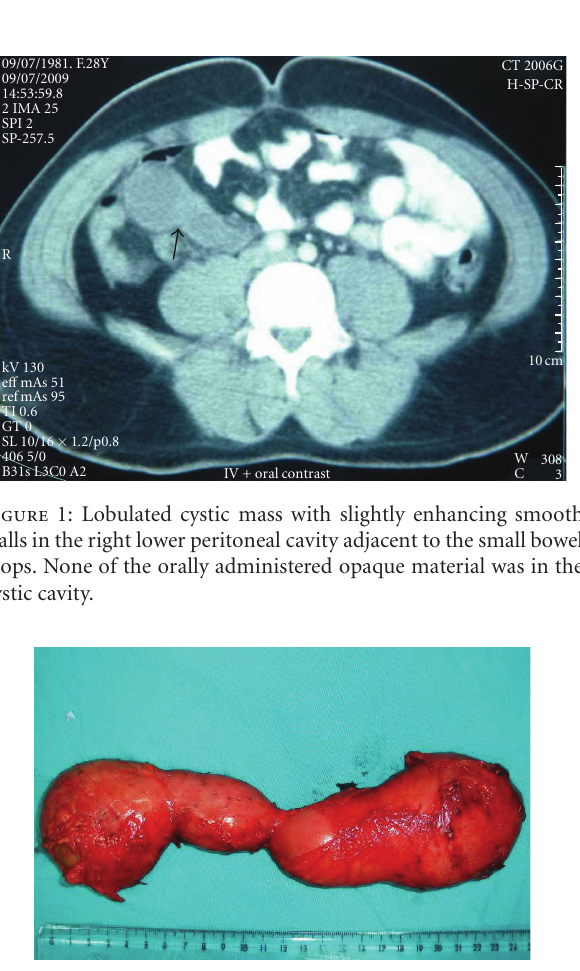
Figure 2: Resected ileal duplication cyst. Intact mucosal layer seen in left pole of